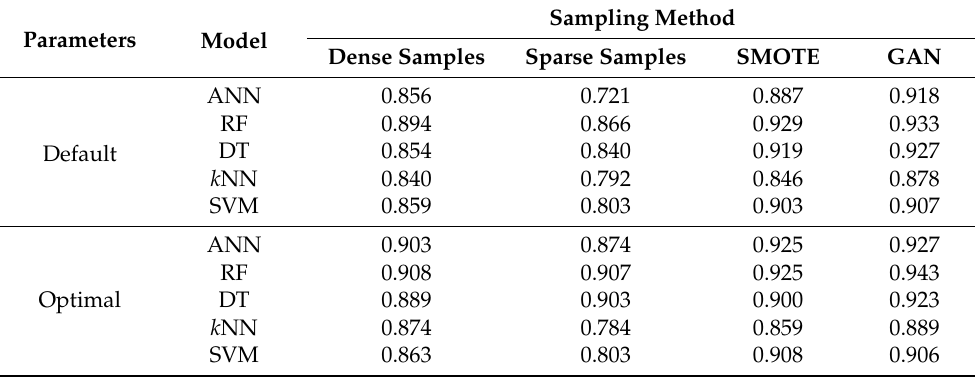
Table A1. Assessment of different sampling methods used in this study with five machine learning models (both default and optimised parameters)–based on